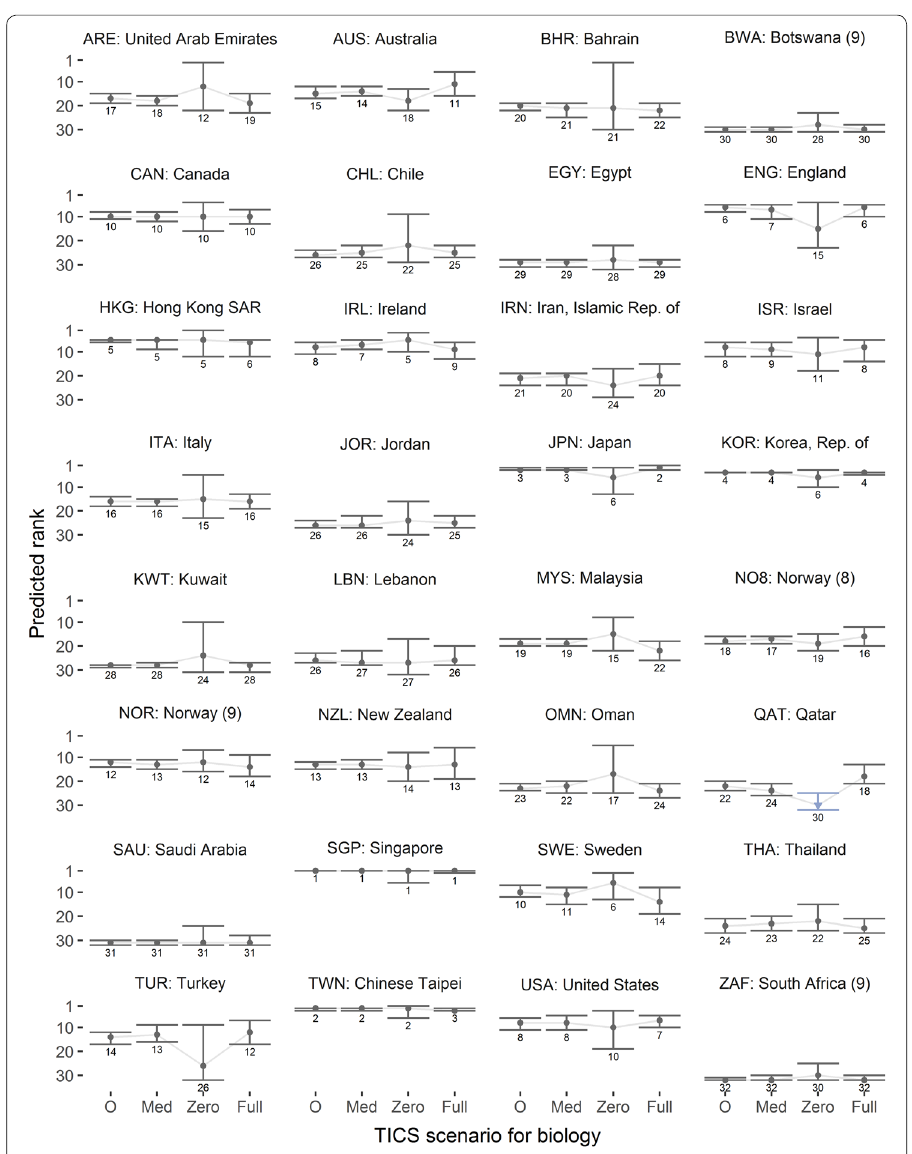
Fig. 14 Predicted rank in biology across TICS scenarios. O Full all schools have implemented the country-specific median, the least possible, or most possible level = of TICS within the country, respectively. A blue confidence interval with a downward arrow indicates a significantly lower rank than the original scenario (e.g. Qatar for zero TICS scenario in